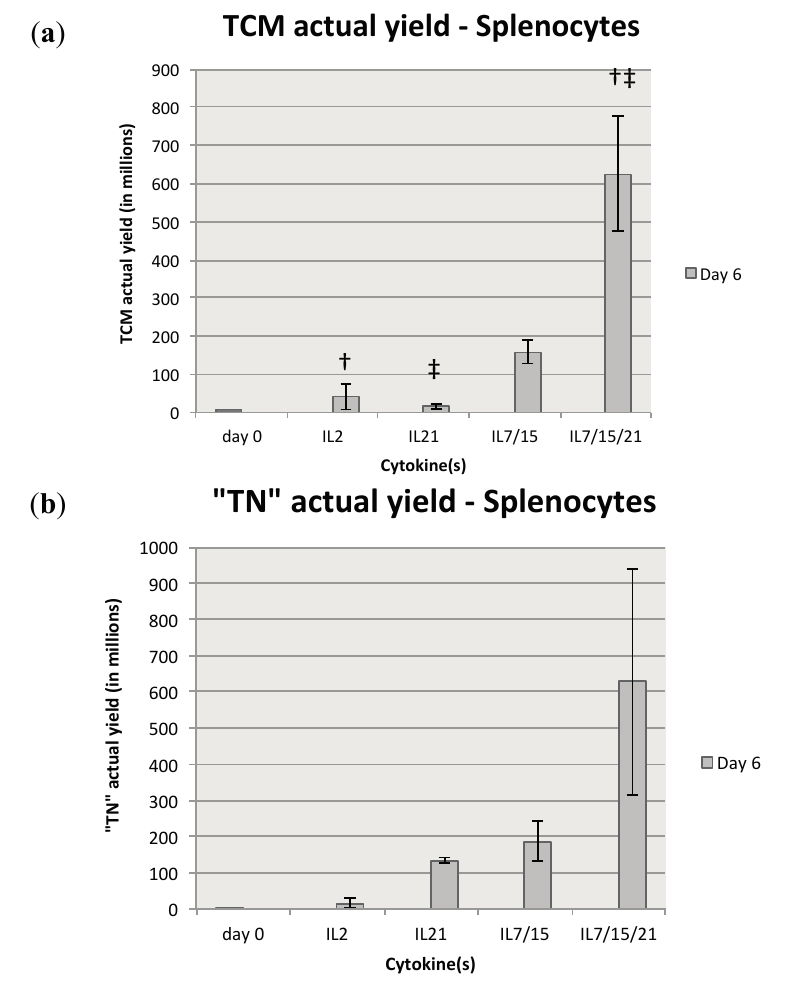
Figure 4. The percentages of CD8+ T CM , † ( vs . IL2) = p < 0.01, ‡ ( vs . IL21) = p = 0.004 ( a ) and CD8+ T N ( b ) splenocytes were multiplied by the number of total cells expanded to obtain actual yield of cells in that